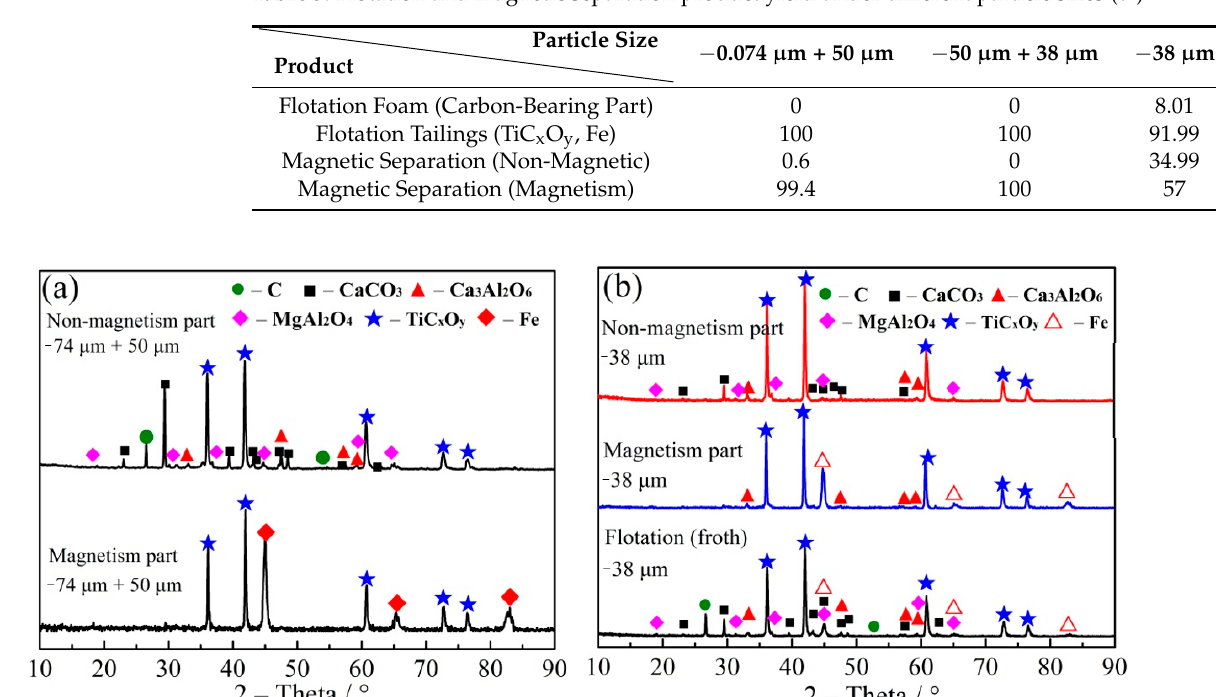
Figure 10. ( a ) XRD of magnetic separation product (particle size: − 50 µ m + 38 µ m); ( b ) XRD patterns of the flotation product and the magnetic and the nonmagnetic parts (particle size: − 38 µ m).